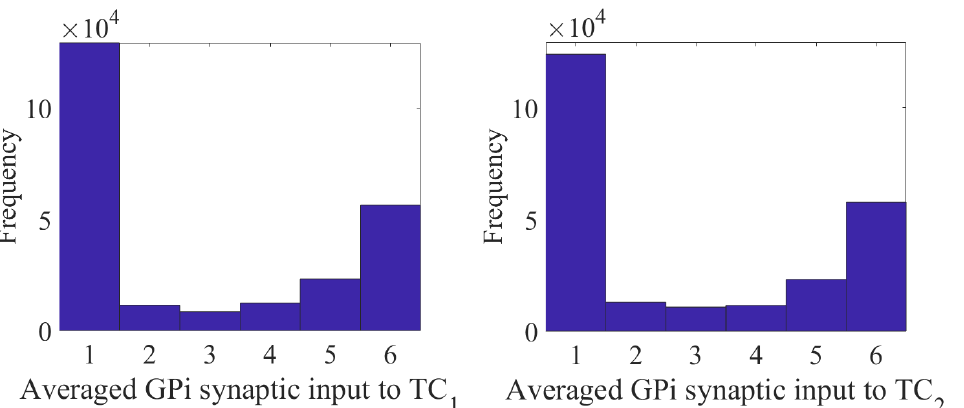
Figure 18. Histograms of sg ( left ) and sg ( right ) in the parkinsonian network, in ms/cm 2 . Both 1 2 histograms include two dominant bins, centered at 1 and 6, due to the quiescent and bursting phases, respectively, of GPi